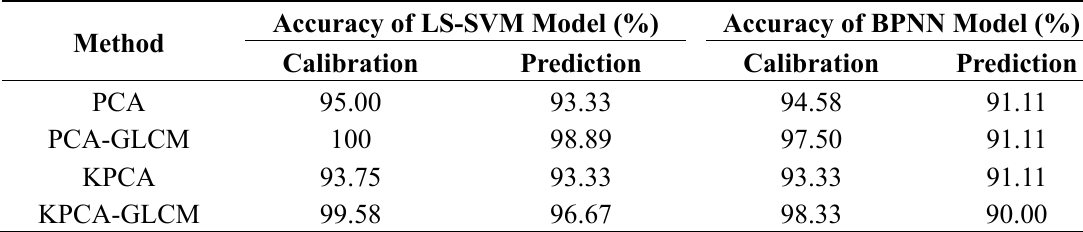
Table 1. Statistic result of discrimination models for